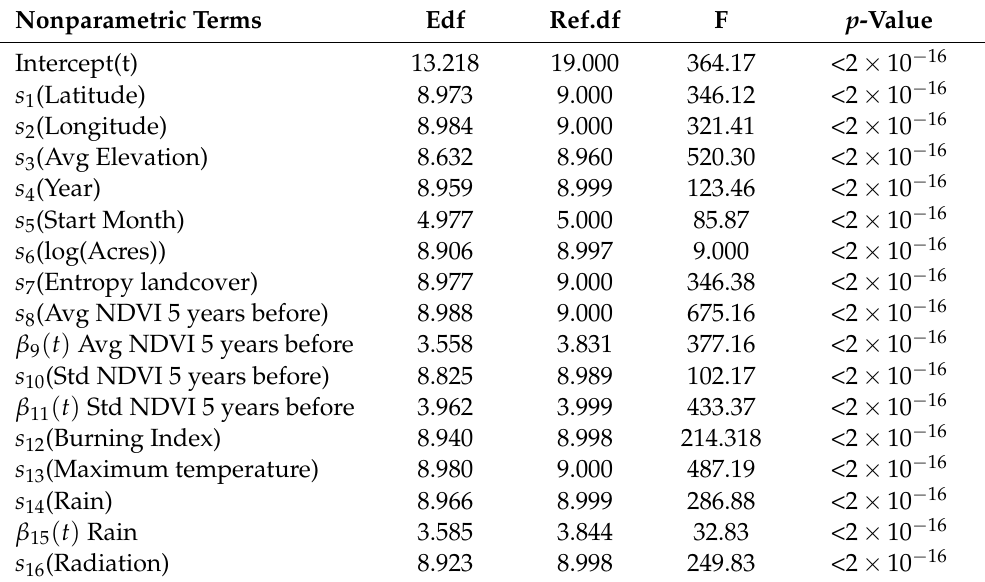
Table 4. Full function-on-scalar additive model. Estimation of the nonparametric terms. Nonparametric Terms Edf